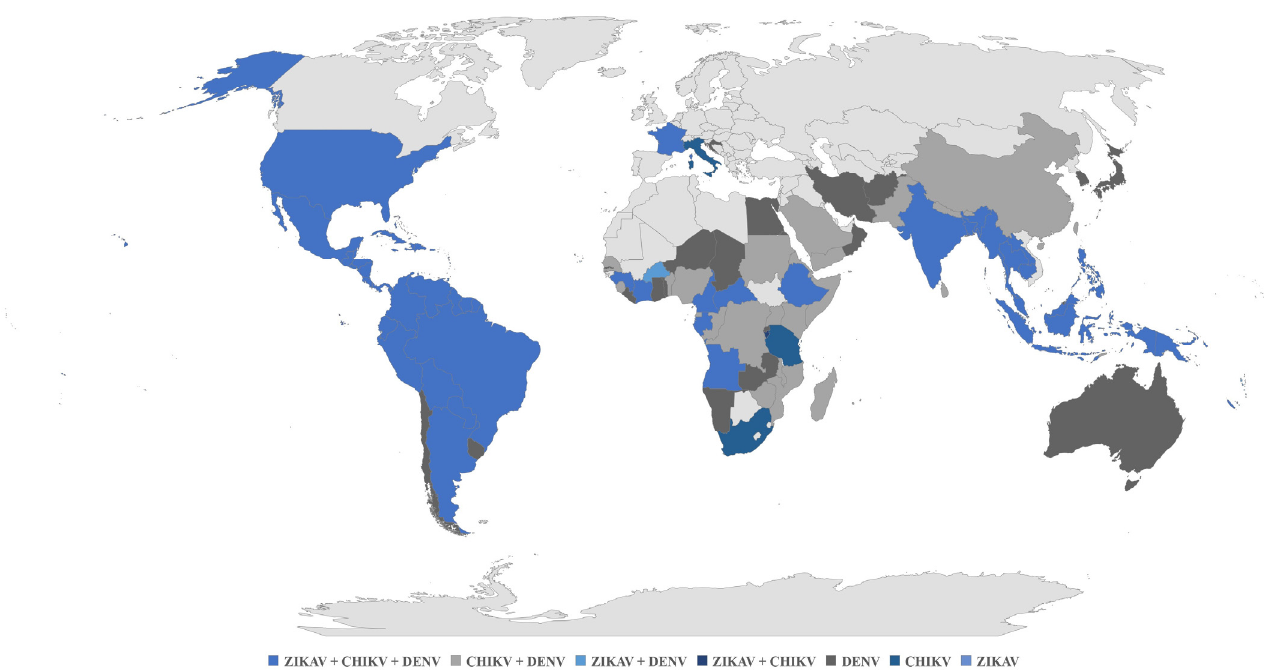
Figure 1. World distribution of DENV, CHIKV and ZIKAV. DENV: Dengue virus; CHIKV: Chikungunya virus; ZIKAV: Zika virus [7–9].